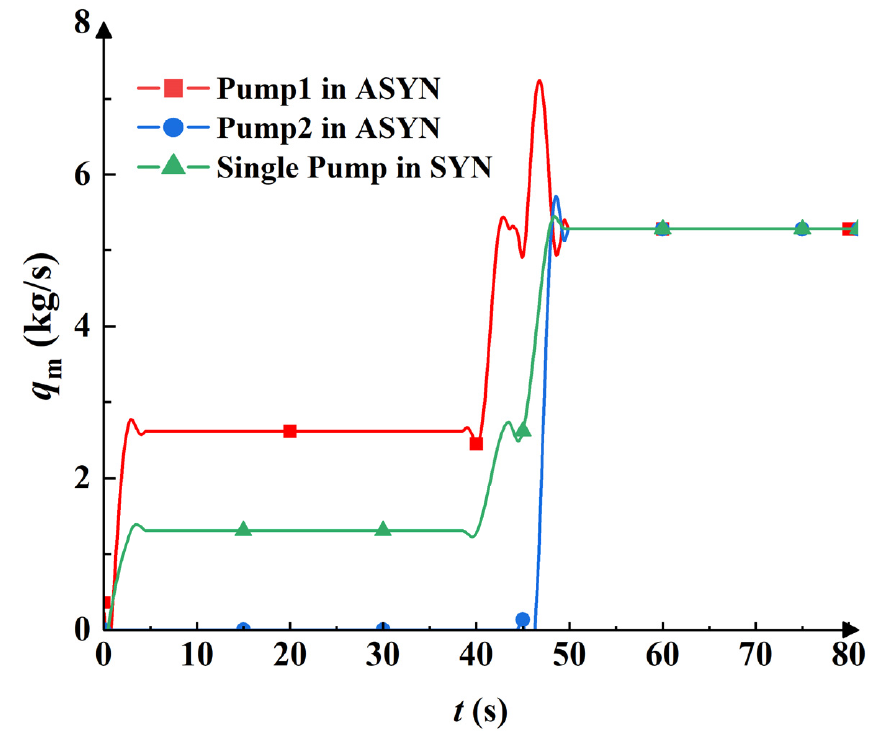
Figure 10. Comparison of flow in Scheme ASYNC vs. Scheme SYNC.